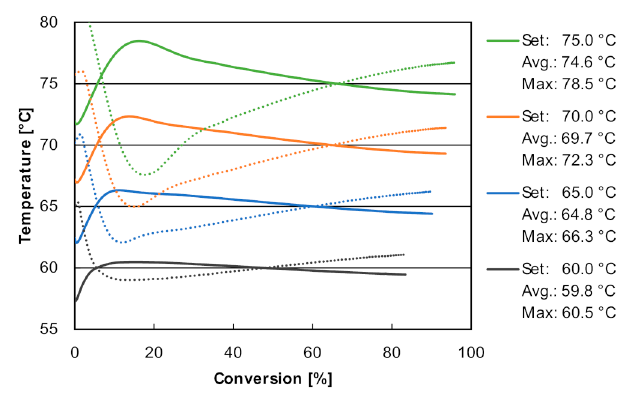
Figure 3. Temperature profile of acrylic acid polymerisations in isopropyl alcohol (150 g/L) initiated with AIBN (1 mol%). Solid lines show the temperatures in the reactor vessel, dotted lines display the corresponding jacket